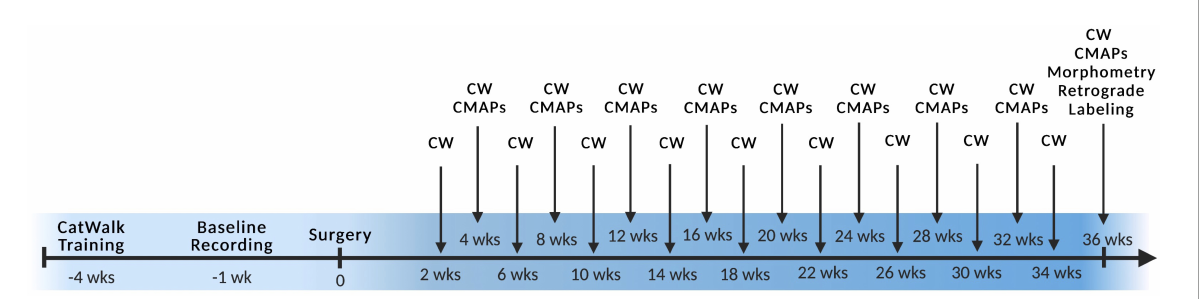
FIGURE2 Experimental timeline. Surgery was performed at week 0 with preoperative training and baseline recordings labeled with negative numbers and all postoperative timepoints labeled with positive numbers. CW, Catwalk; CMAPs, compound muscle action potentials. n = 5 for sciatic autograft group, n = 6 for sciatic autograft, inbred sciatic allografts, and inbred femoral allografts